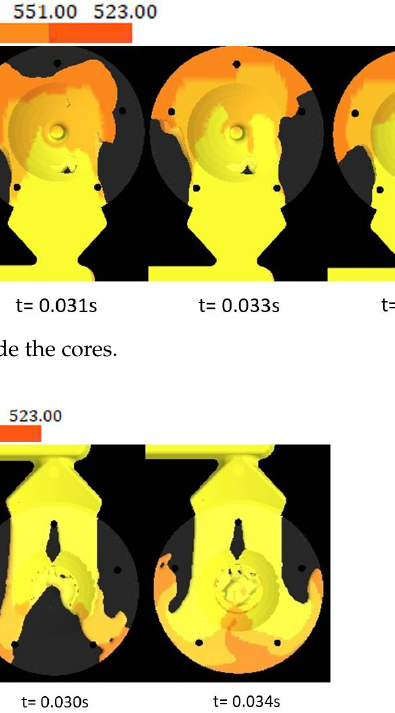
Figure 6. The melt jet is directed right towards the core.